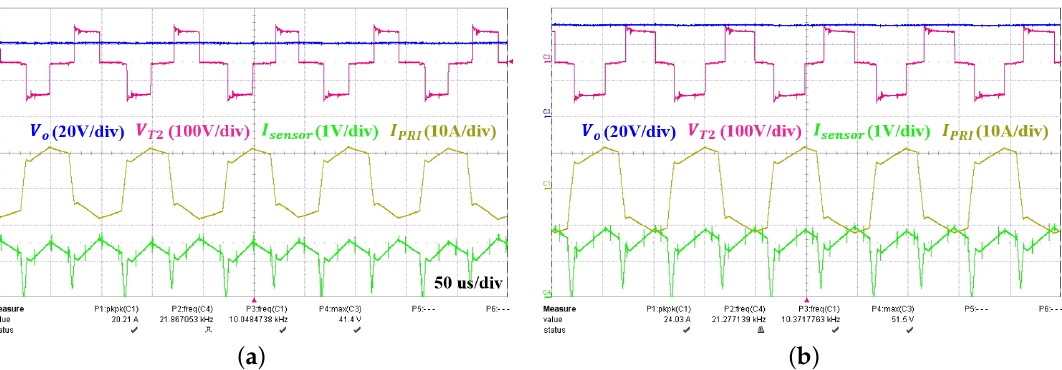
Figure 20. Experimental current and voltage waveforms of the proposed HCMC: ( a ) V o = 40 V; ( b ) V o = 50 V; ( V o = 20 V/div, V T 2 = 100 V/div, I sensor = 1 V/div, I PRI = 10 A/div).